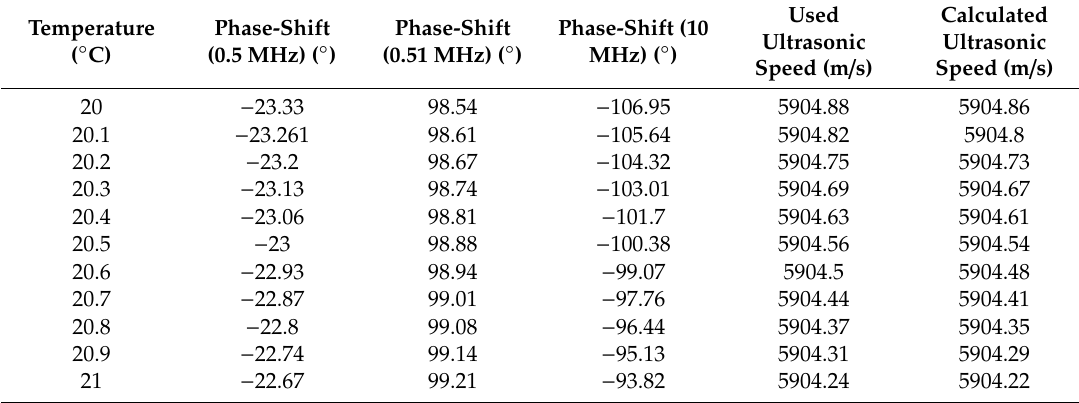
Table 3. Simulation results using multiple frequency continuous wave method (MFcw) technique.